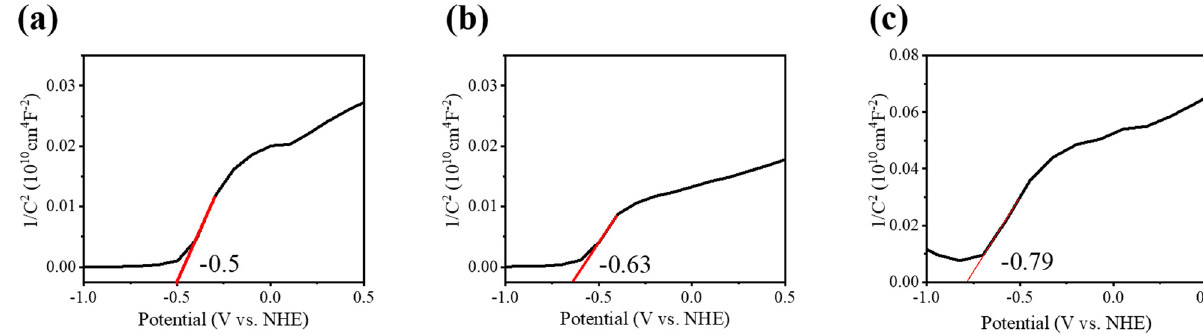
Figure 9: Mott – Schottky plots of various products: ( a ) ZnO, ( b ) ZS - 1, and ( c